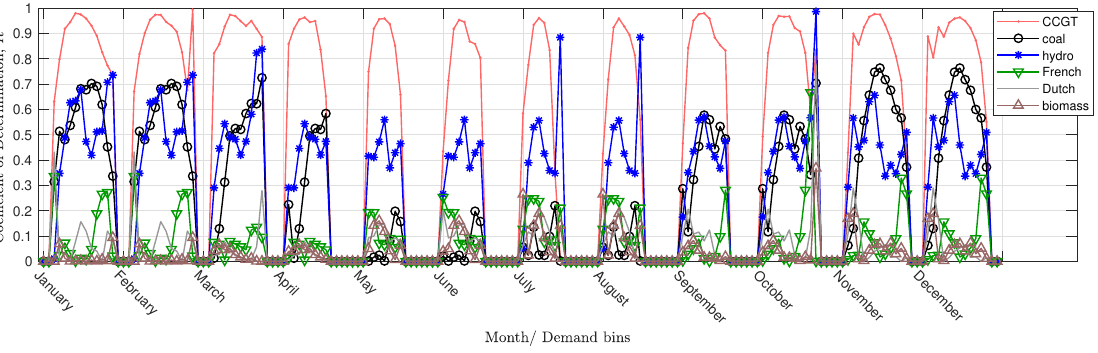
Figure 3. R 2 values for linear regressions of ∆ P j against ∆ D , for j = CCGT, coal, hydroelectric, French and Dutch interconnectors, and biomass, binned by month and by demand D (<20 GW,